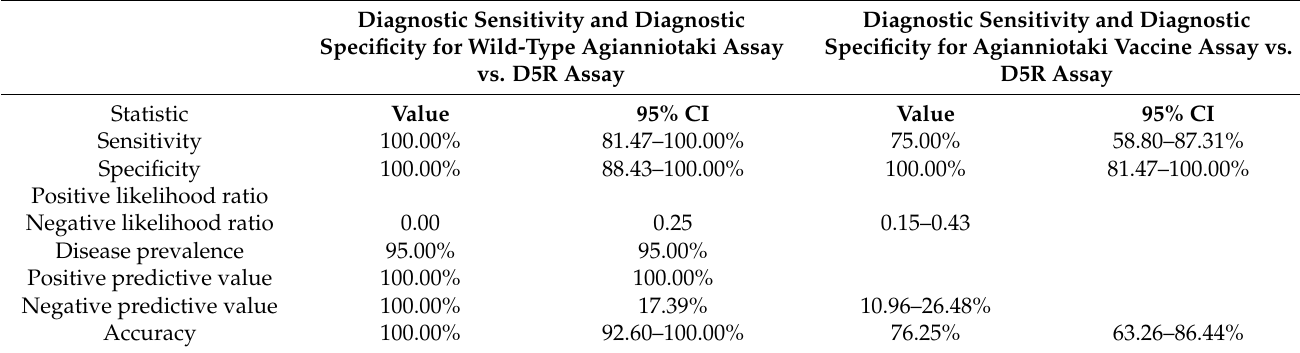
Table 11. Diagnostic sensitivity and diagnostic specificity for the Agianniotaki assay vs. D5R